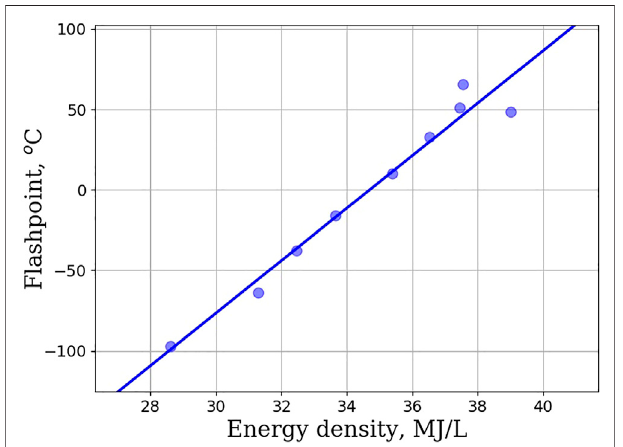
FIGURE 5 | Melting point (in degrees Celsius) as a function of density (in kg/m 3 ) for 5 and 6 membered rings within the monosubstituted linear cycloalkane